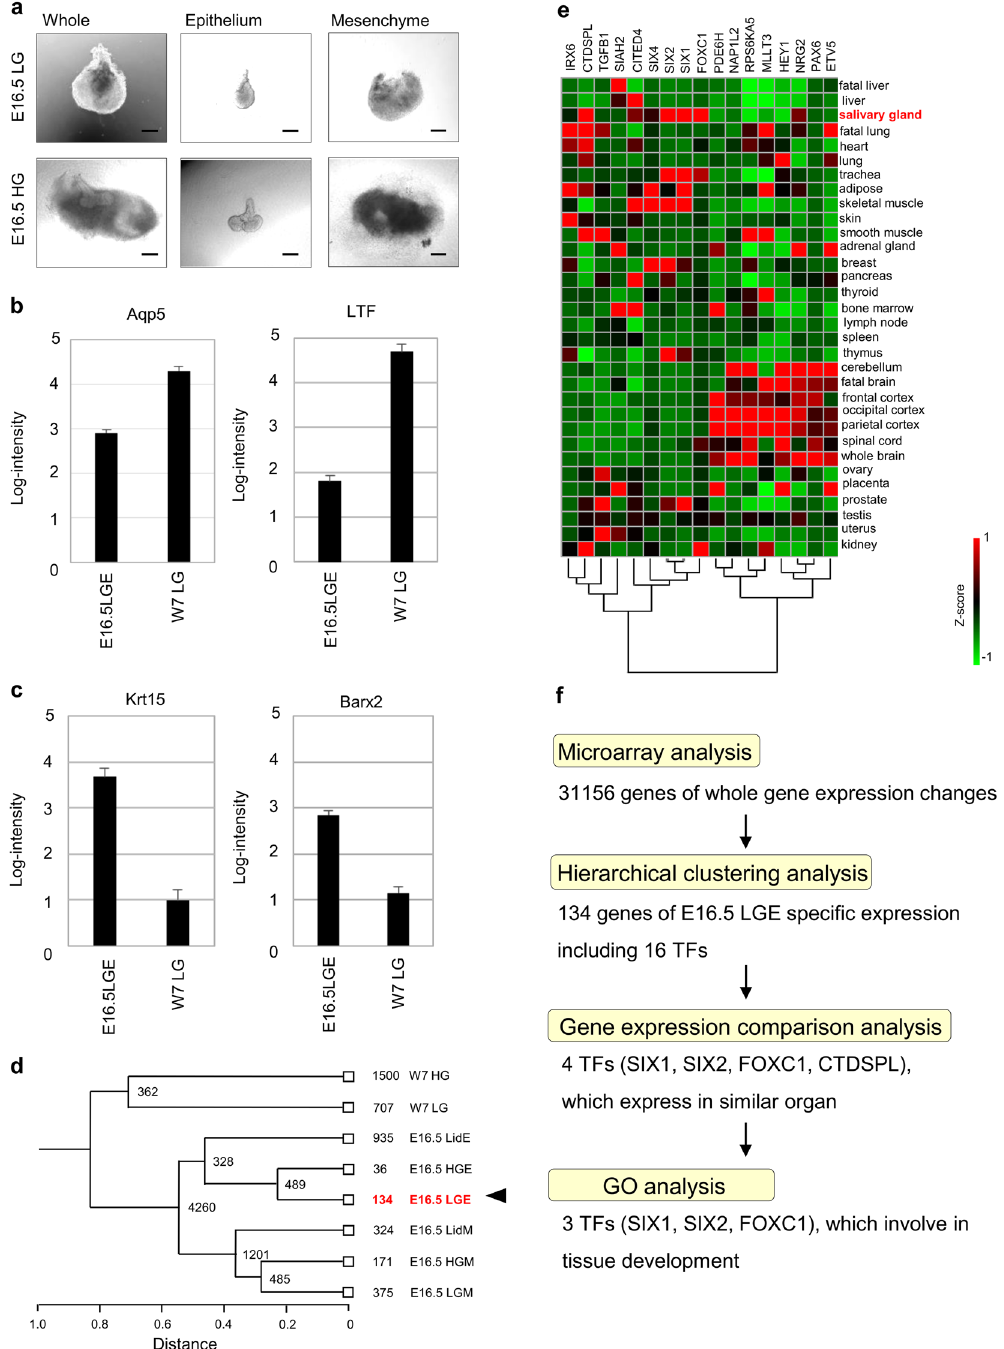
Fig. 1 Identi fi cation of tissue speci fi c TFs for LGE. a Phase-contrast microscopic images of E16.5 mouse lacrimal gland ( upper ) and harderian gland ( lower ). Images of whole ( left ), separated epithelium ( center ), and separated mesenchyme ( right ) are shown. Scale bar 100 µm. b The gene expression comparison of mature LGE markers in the microarray analysis between E16.5 LGE and W7 LG. E16.5 embryonic day 16.5, LGE lacrimal gland epithelium, W7 LG 7-week-old mouse lacrimal gland. c The gene expression comparison of LGE markers in the microarray analysis between E16.5 LGE and W7 LG. E16.5 embryonic day 16.5, LGE lacrimal gland epithelium, W7 LG 7-week-old mouse lacrimal gland. d Hierarchical clustering analysis. The number of speci fi c genes is shown. W7 LG 7-week-old mouse lacrimal gland, W7 HG 7-week-old mouse harderian gland, E16.5 embryonic day 16.5, LGE lacrimal gland epithelium, LGM lacrimal gland mesenchyme, HGE harderian gland epithelium, HGM harderian gland mesenchyme, LidE eyelid conjunctiva epithelium, LidM eyelid conjunctive mesenchyme. e Gene expression pro fi les of 16 TFs among 134 genes and PAX6 analyzed by web database tool. Foxc1, Six1, Six2, and Ctdspl express highly also in salivary glands, which are secretory glands similar to the lacrimal glands. Heat map ( Green to red ) represents a Z -score among organs. f Flowchart of an approach to identify premature lacrimal gland epithelium speci fi c transcription